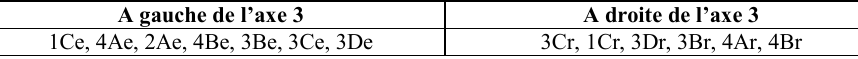
Tableau 7. Positionnements des modalités sur l’axe